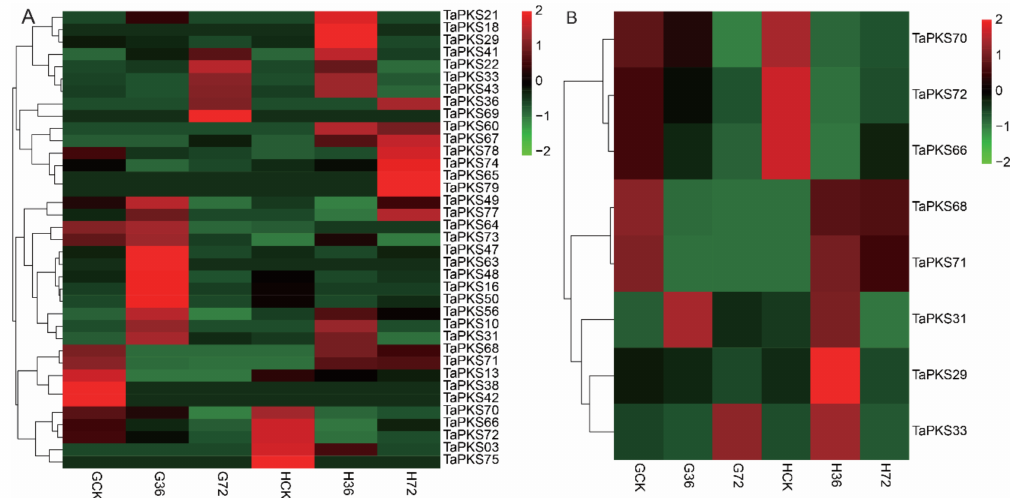
Figure 9. Expression profiles of TaPKS genes after infection by Rhizoctonia cerealis : ( A ) expression profiles of TaPKS genes in the resistant material H83 and susceptible material 7182 after inoculation; ( B ) expression profiles of eight differentially expressed TaPKS genes in the resistant material H83 and susceptible material 7182 after inoculation. Values of fragments per kilobase of transcripts per million mapped reads (FPKMs) are represented by a color gradient from low (green) to high